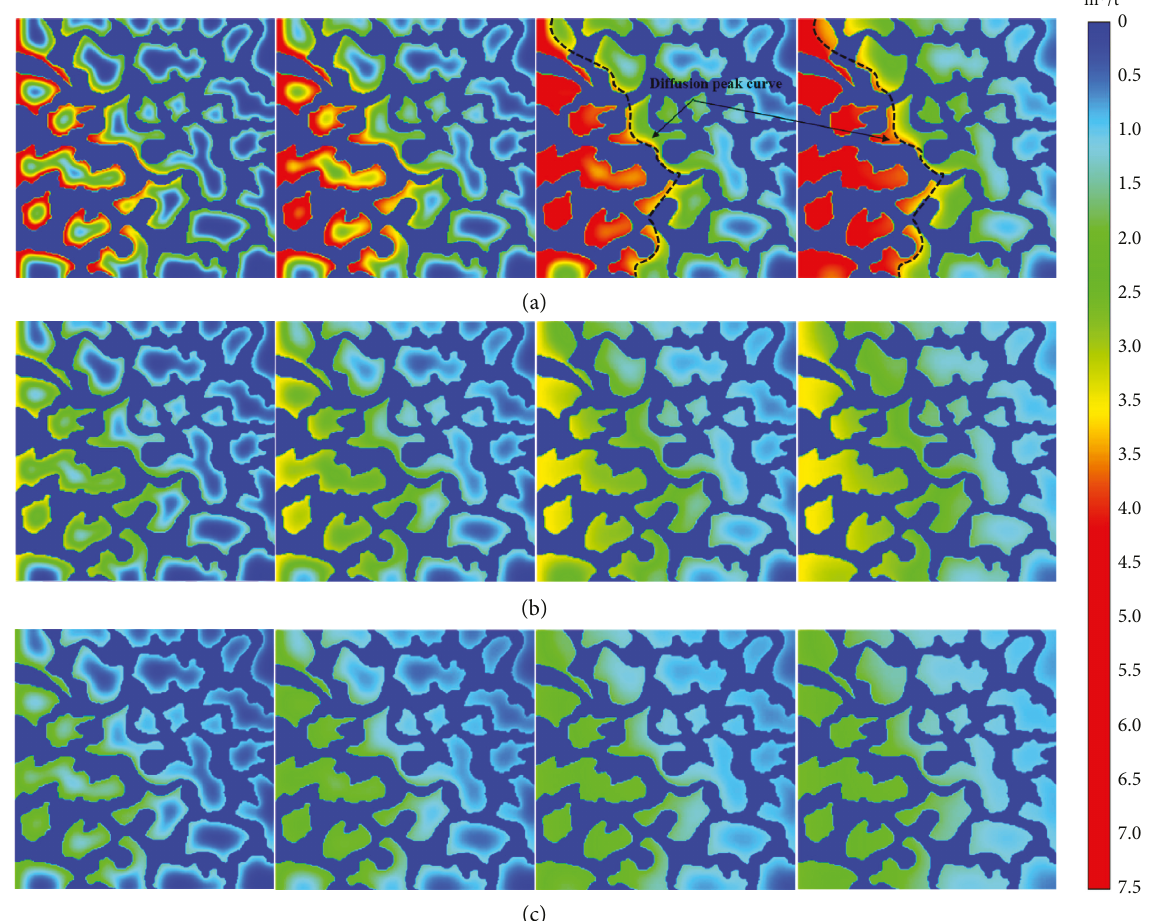
Figure 9: Magnitude and distribution of the adsorbed amount in the porous medium varying the matrix porosity and the Langmuir pressure, respectively. (a) p L = 1 MPa , (b) p L = 2MPa , and (c) p L = 3MPa . According to the isothermal adsorption equation in (14), the maximum adsorbed amounts in cases (a), (b), and (c) are 7.6, 4.4, and 3.1m 3 /t, respectively. The porosities of the permeable solid from the left to right columns are 0.05, 0.1, 0.2, and 0.4,